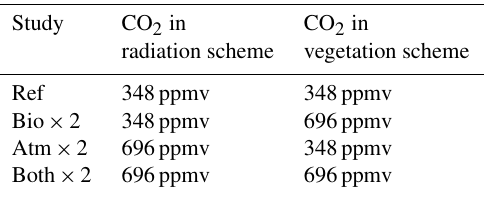
Table 1. Prescribed CO 2 in the radiation and vegetation schemes for different